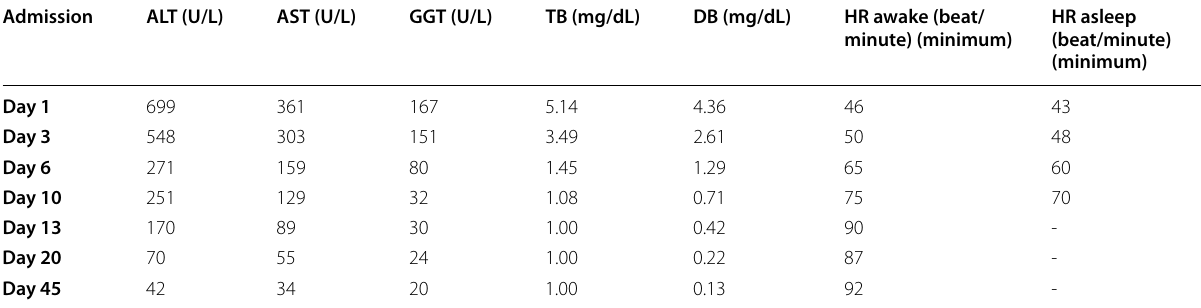
Table 1 Laboratory and heart rate beats per minute on the 1st, 3rd, 6th, and 10th day of admission